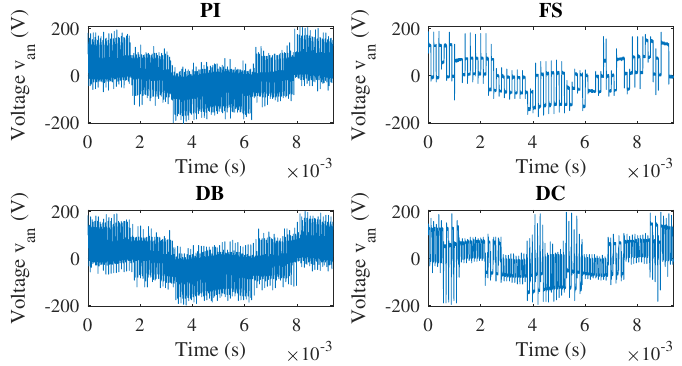
Figure 11. Phase voltage in phase a for one electrical period ( V dc = 200 V; N = 800 rpm; i ∗ q = 6 A).